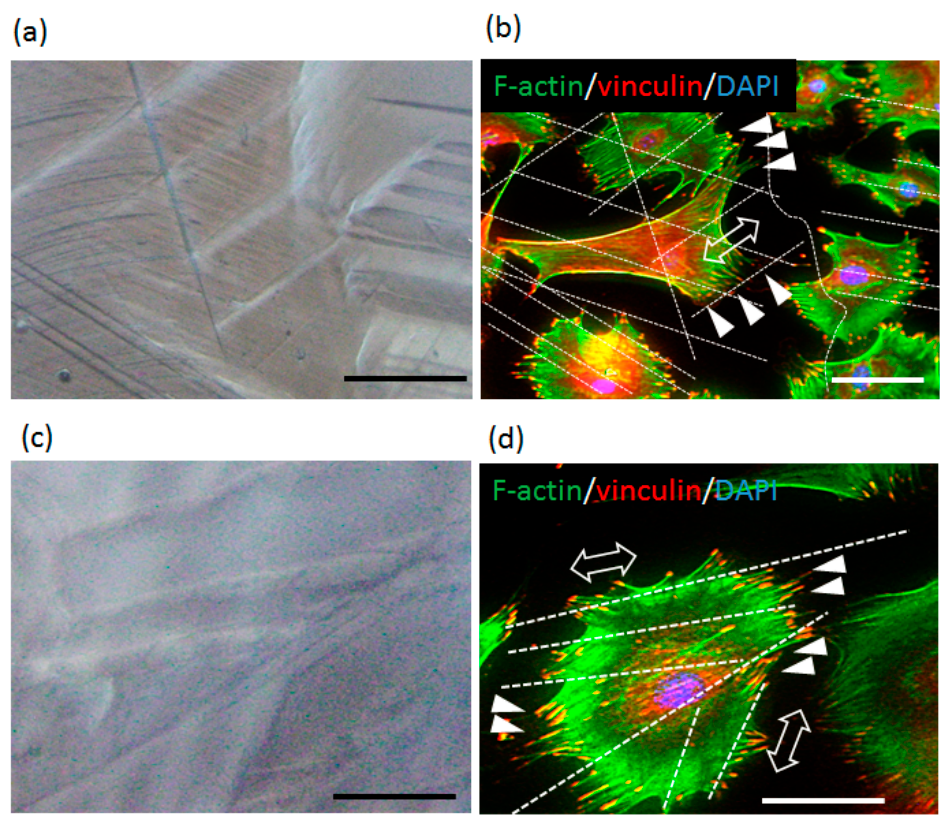
Figure 3. Immunocytochemical analysis of the osteoblasts cultured on surface topography introduced by plastic deformation. Optical microscopic images of ( a,c ) surface relief and ( b , d ) cellular cytoskeleton proteins. Arrows indicate the direction of slip and/or twinning traces. Arrowheads indicate the mature focal adhesions accumulated between slip and/or twinning traces. Green, F-actin; red, vinculin; blue, nuclei. Scale bar: 100 μ m.